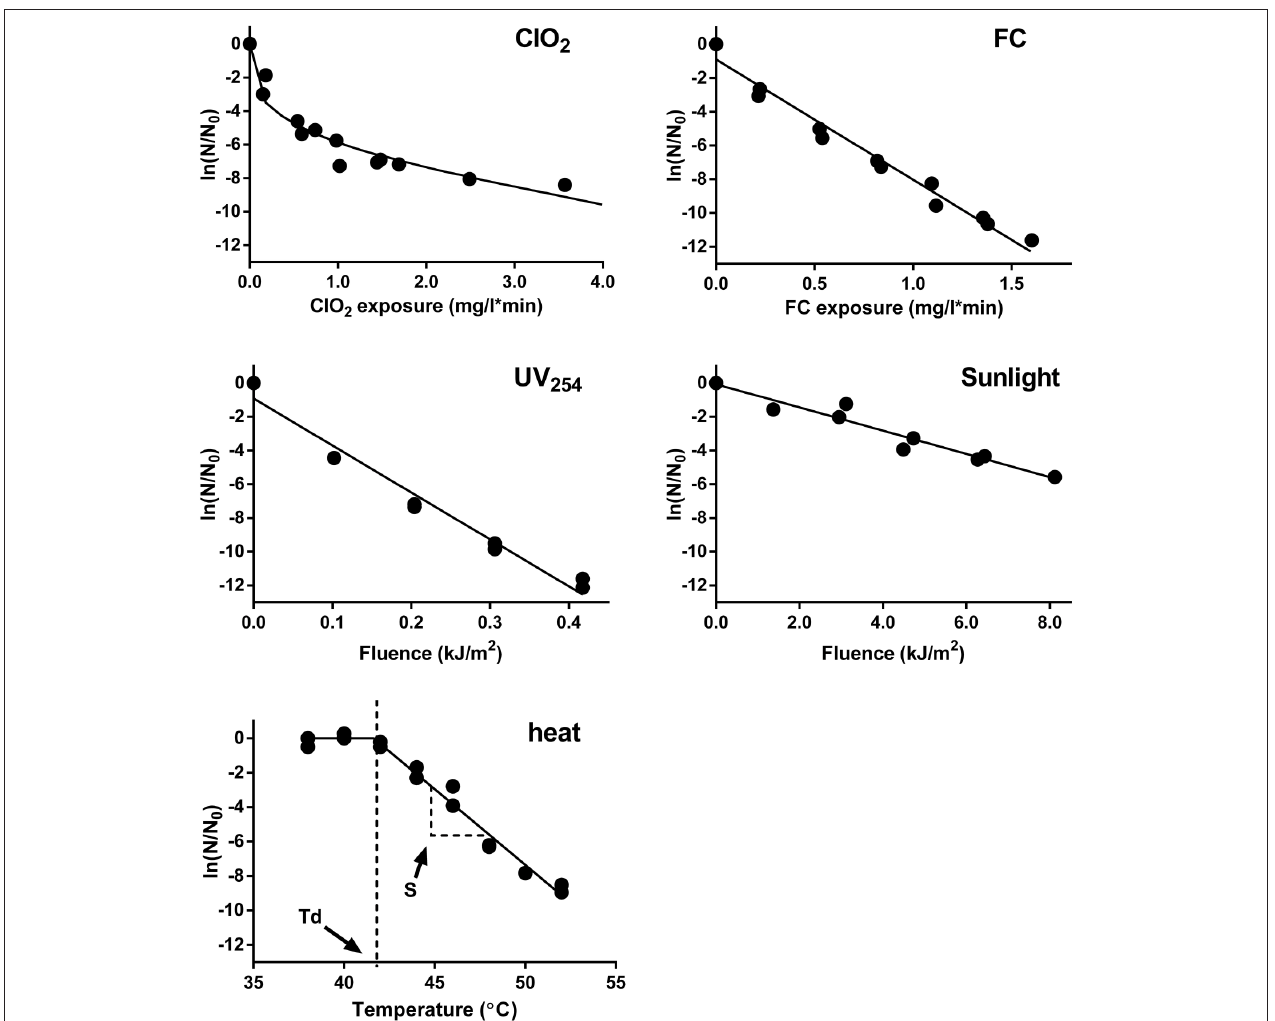
FIGURE 2 | Inactivation of E11 (WT) by ClO 2 , FC, UV 254 , sunlight, and heat. Infectivity loss (ln ( N/N 0 )) is plotted against disinfectant exposure for ClO 2 and FC exposure, fluence dose for UV 254 and sunlight, and temperature for heat inactivation. Experimental data was fitted using the modified Hom model (ClO 2 ), Chick-Watson model (FC, UV 254 and sunlight), and segmental linear regression (heat). Model fits are shown as solid lines. Results from duplicate experiments are